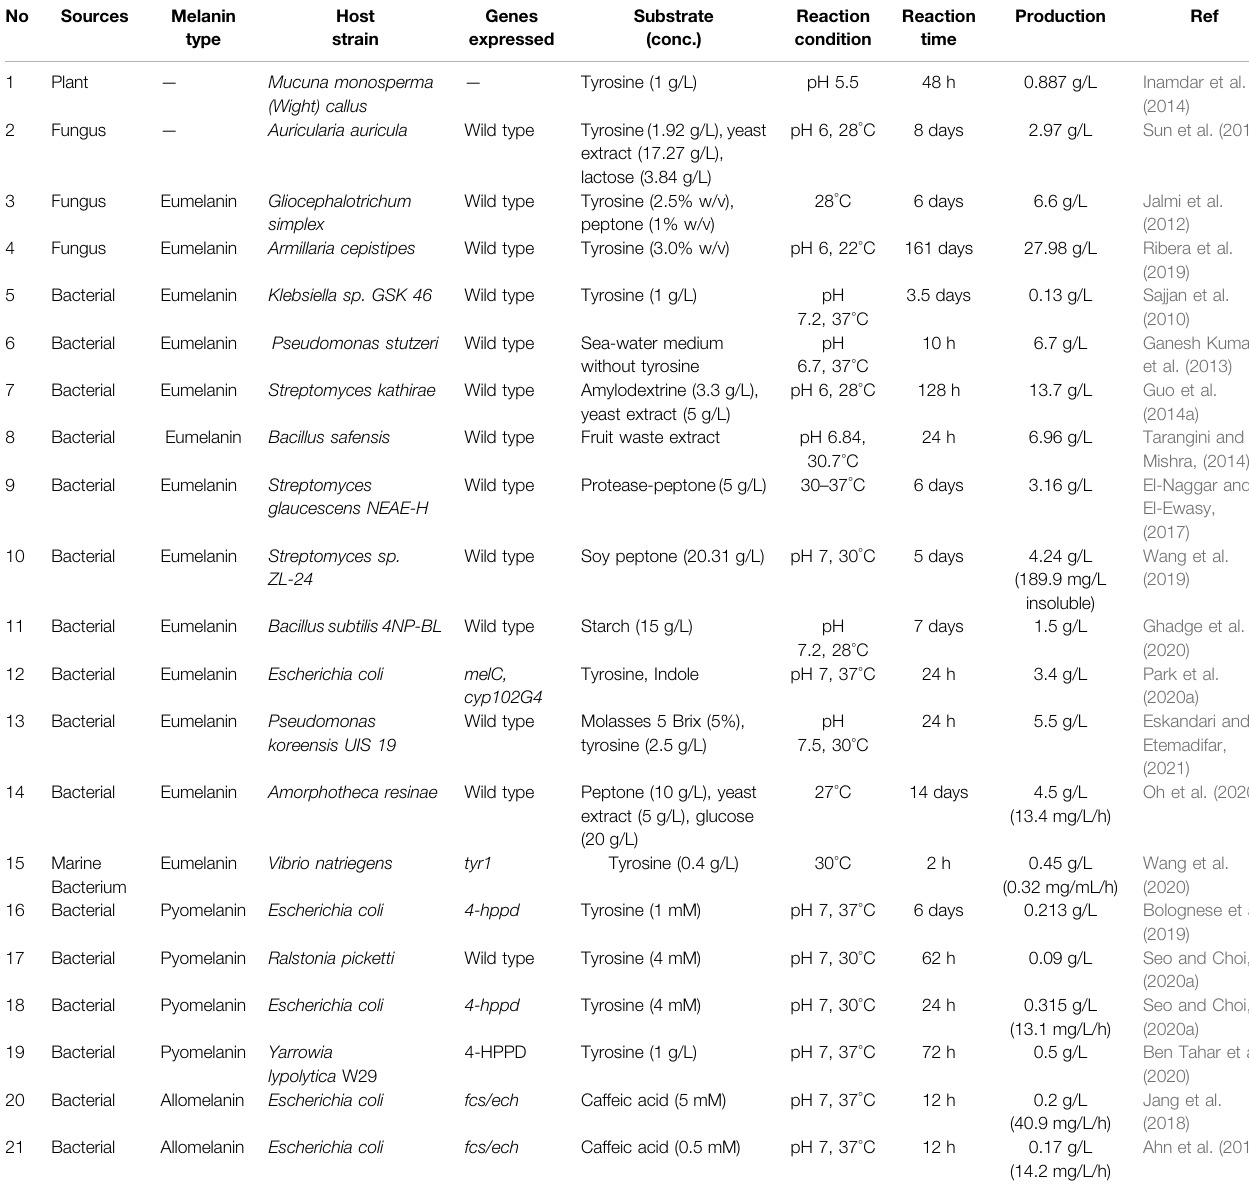
TABLE 1 | Production of microbial melanin in a biore fi nery